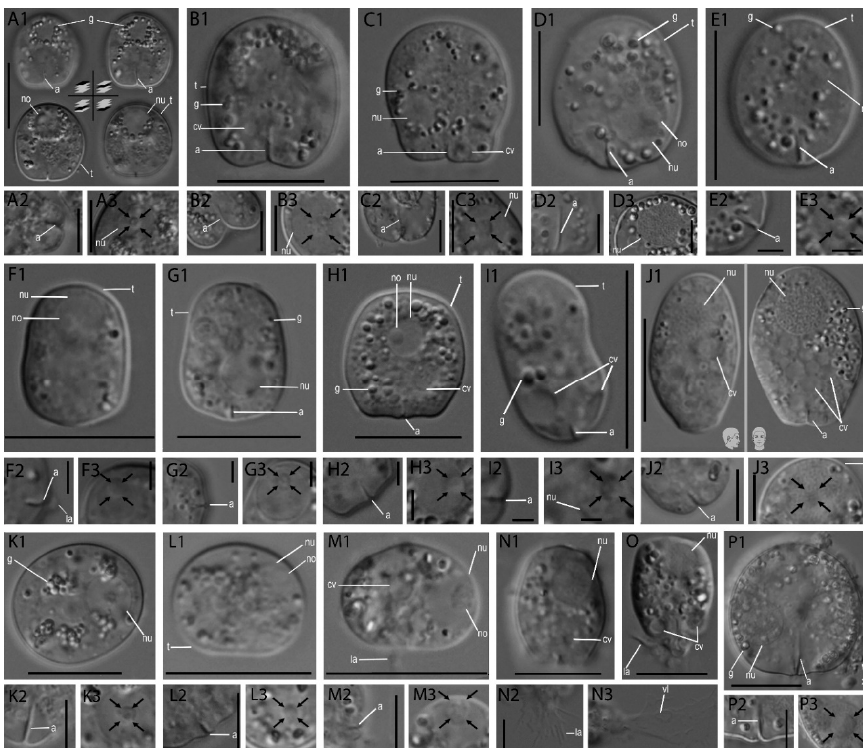
Figure 1. Cellular features of Rhogostoma spp. found in this study. Pictures of each strain are divided into ( 1 ) cell body as an overview (scale bar 10 µm); ( 2 ) close-up of the aperture (scales bars 5 µm) ( 3 ) close-up of the nucleus, with the nucleolus being highlighted by arrows (scales bars 5 µm). ( A ): R. kyoshii strain WM, ( B ): R. medica strain il-I, ( C ): R. epiphylla strain IGS, ( D ): R. karsteni strain 3A, ( E ): R. tahiri strain B10, ( F ): R. florae strain K8, ( G ): R. florae strain K9, ( H ): R. leviosa strain W2, ( I ): R. pseudocylindrica strain RC, ( J ): R. kappa strain 1A, ( K ): R. epiphylla strain WH4, ( L ): R. absidea strain W3, ( M ): R. micra strain 1B, ( N ): R. radagaster i strain TG4-II, ( O ): R. radagsteri strain TG-IV,